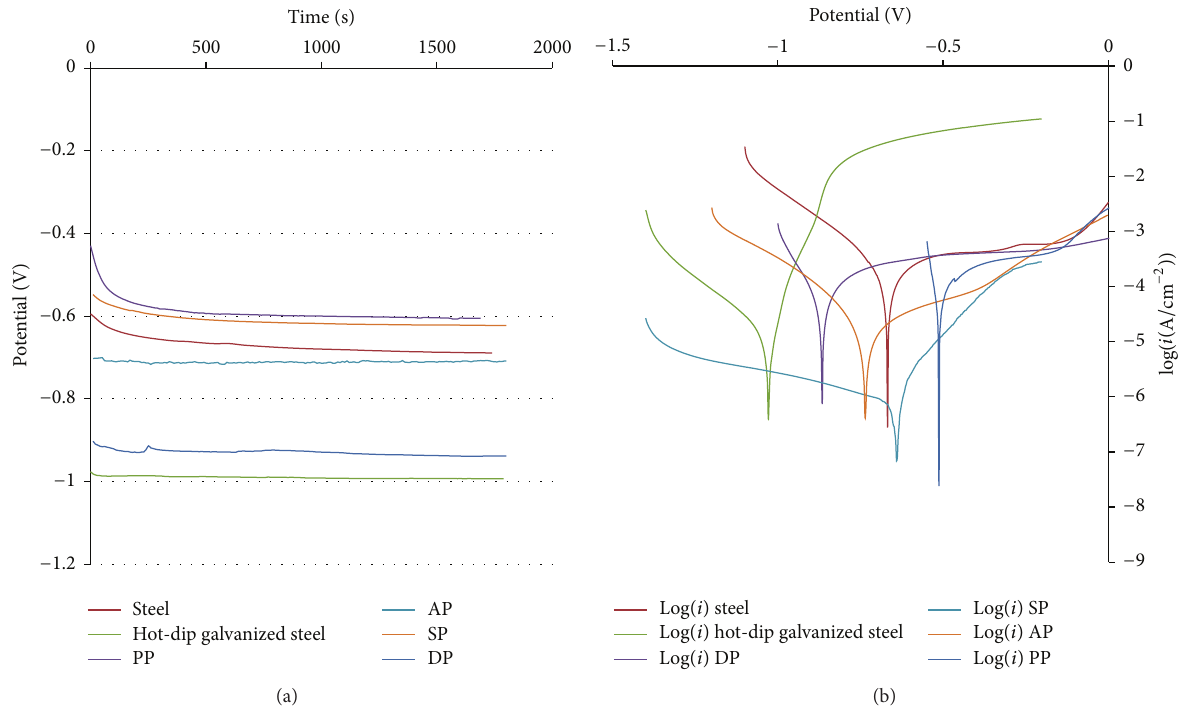
Figure 7: (a) OCP evolution of bare steel, hot-dip galvanized steel, and different primers applied on hot-dip galvanized steel immersed in a 5 wt% NaCl solution; (b) potentiodynamic polarization curves of bare steel, hot-dip galvanized steel, and different primers applied on hot-dip galvanized steel immersed in a 5wt% NaCl solution.